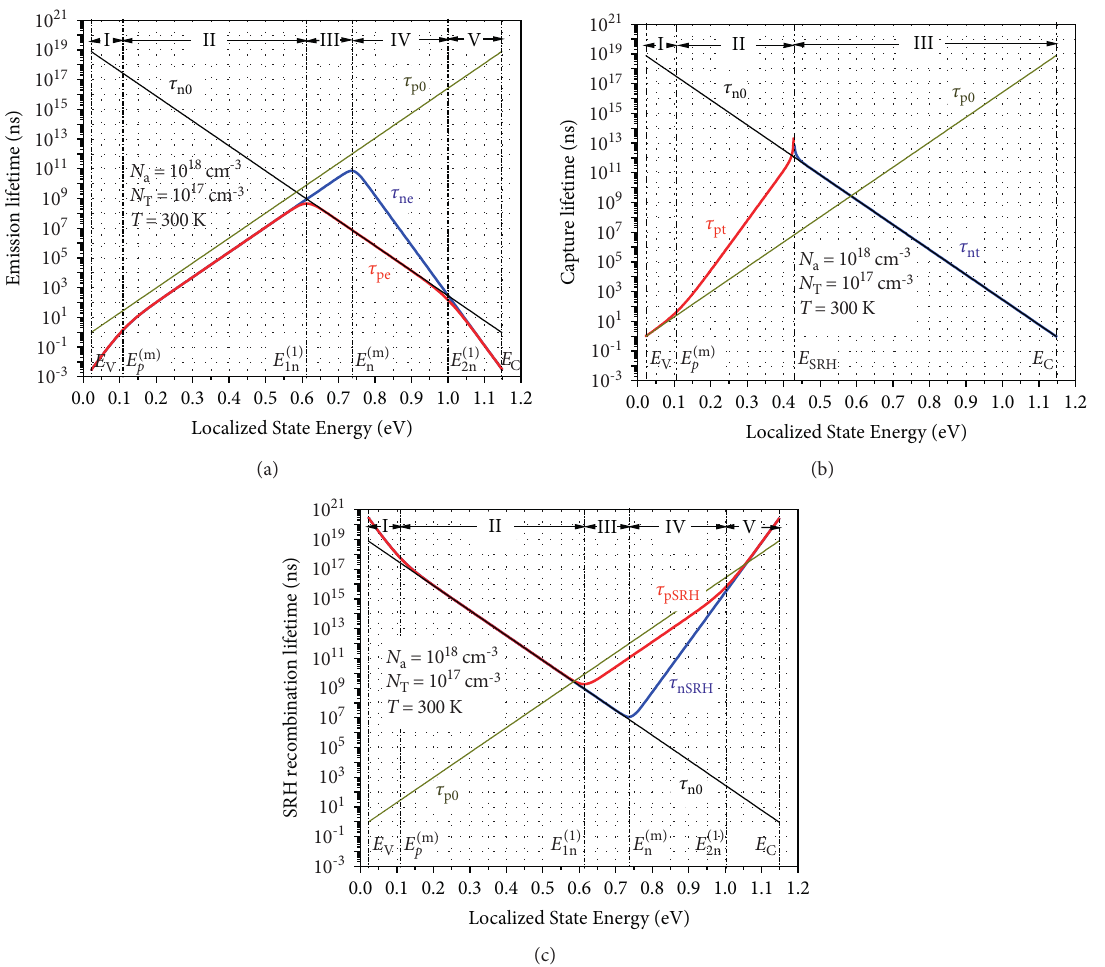
and τ , (b) τ and τ , and (c) τ n and τ p for the system ne pe nt pt SRH SRH